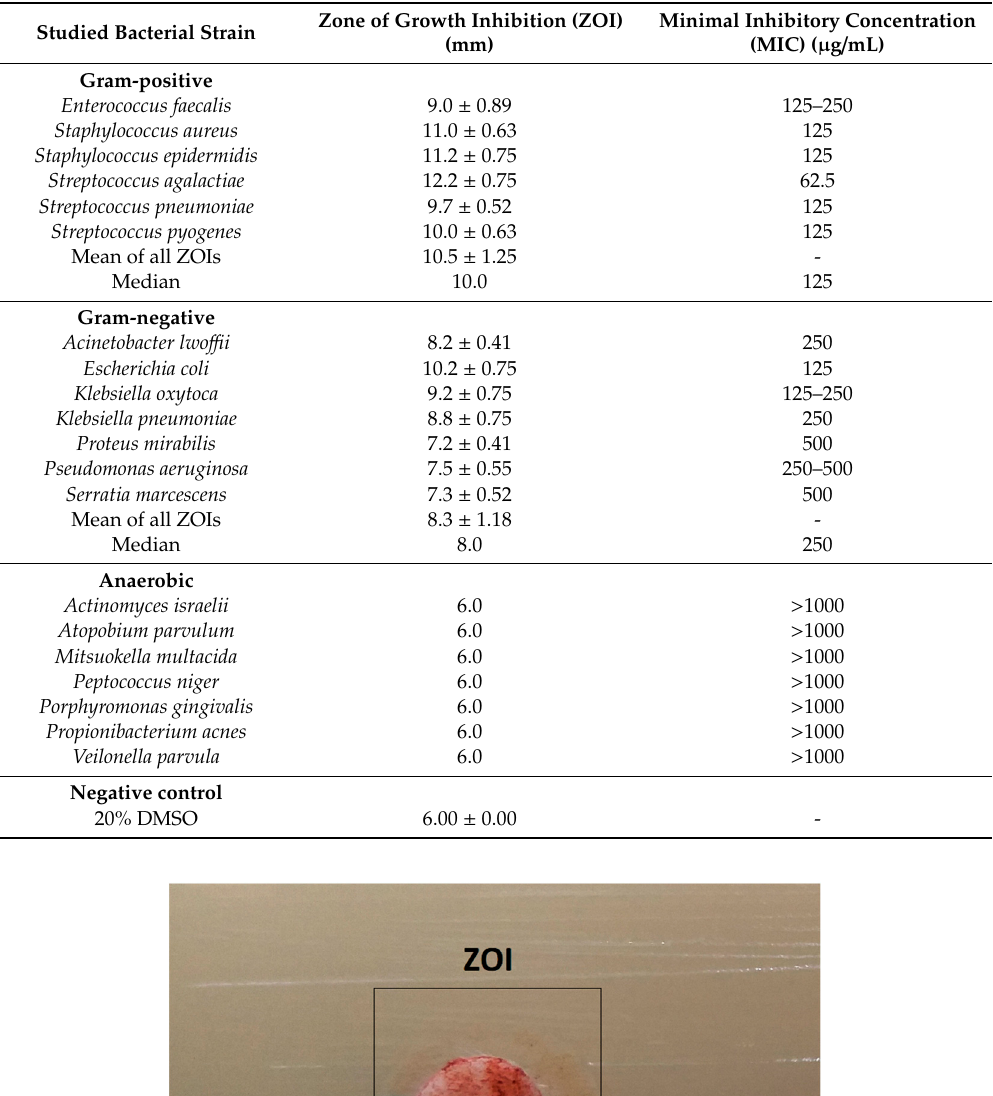
Table 1. Antibacterial activity of fucoxanthin determined by the agar disc-di ff usion and micro-dilution methods.